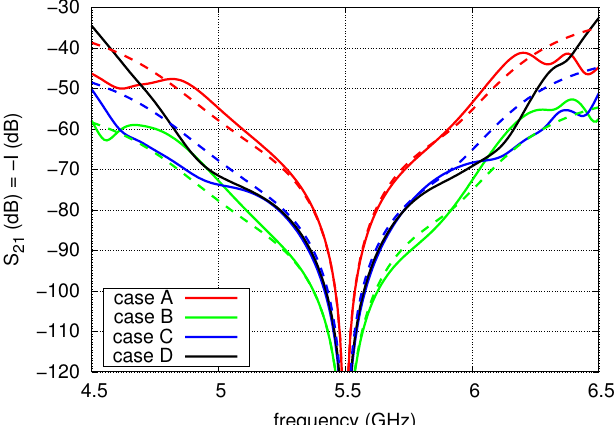
Figure 9. Isolation versus frequency of the four analysed cases of FN.